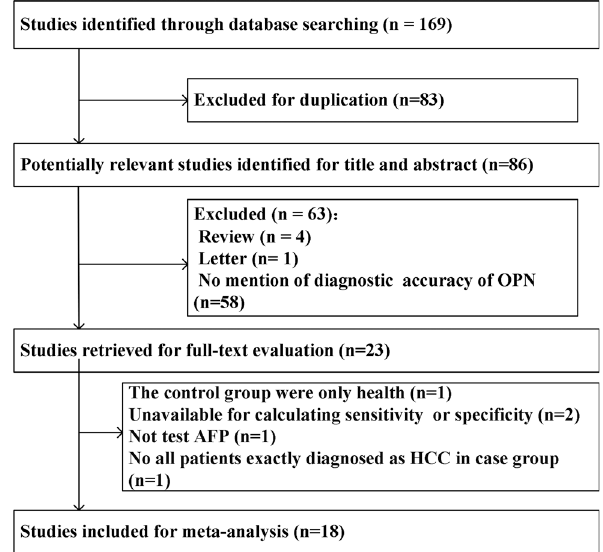
Figure 1: Article selection